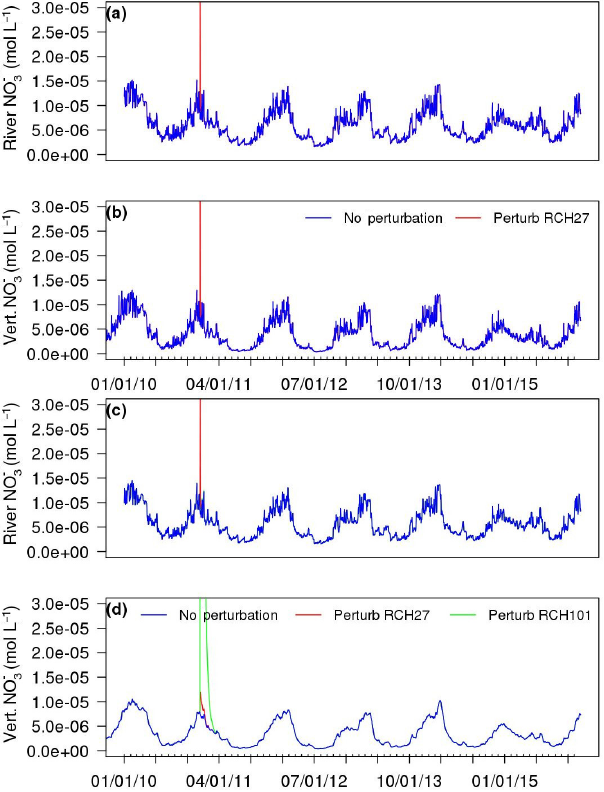
Figure 8. Nitrate concentration in the stream and vertical HZ at RCH27 (a, b) and at the outlet (c, d) with and without HZ perturba- tion using MRMT+BGC.